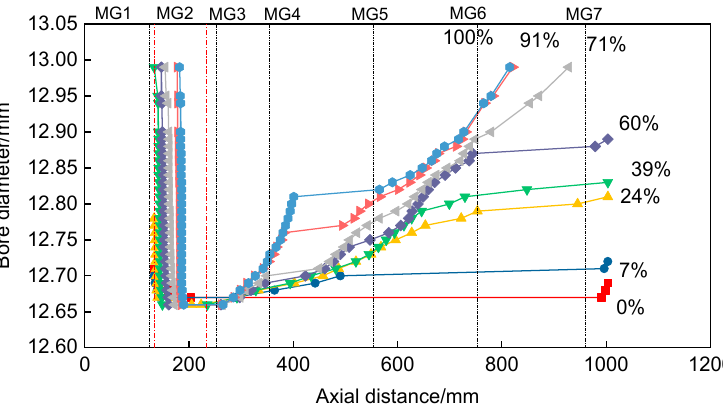
Figure 2. Variation of bore diameter of a gun barrel during the 0–100% life span.